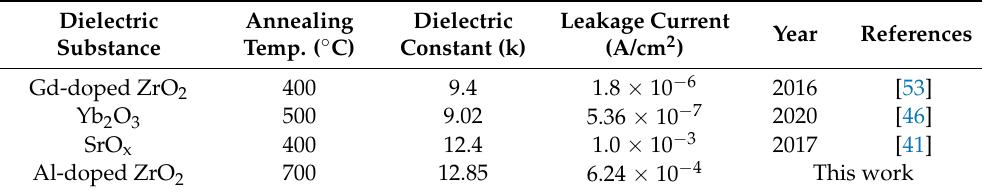
Table 2. The related electrical parameters of some dielectric materials are reported in the literature and in this work.